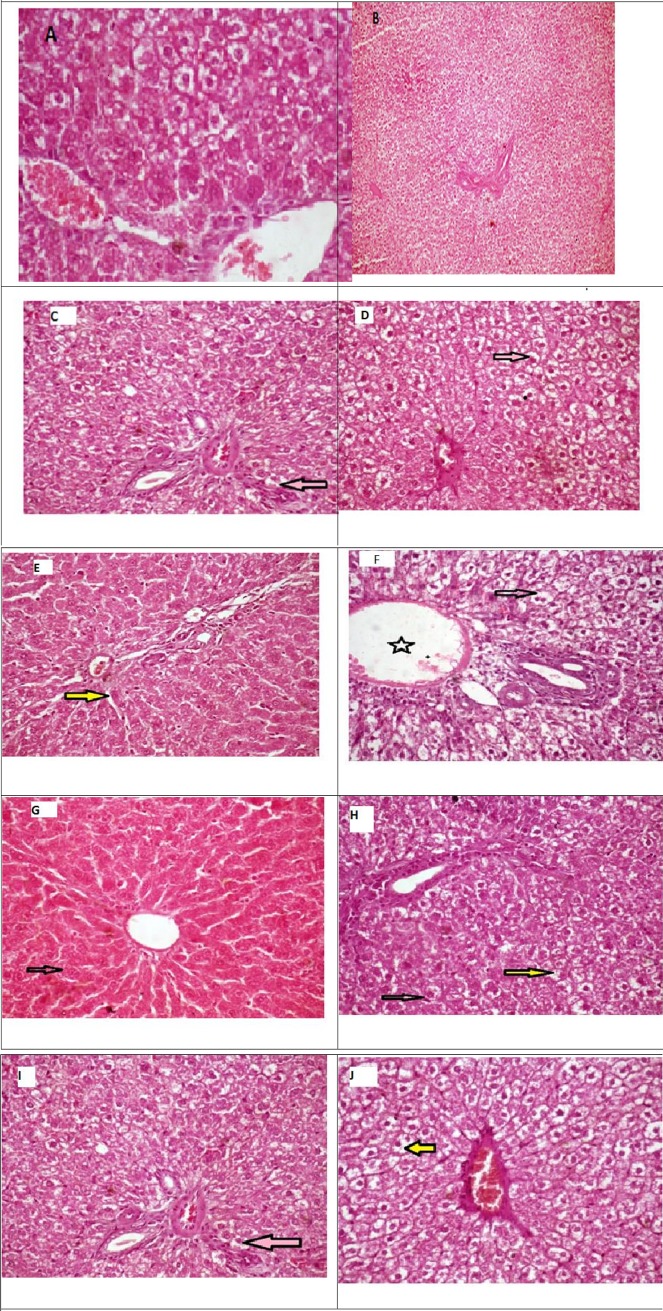
A and B are photomicrograph of livers of control rats (H&E 200 & 100.); (c) Photomicrograph of liver section of tramadol-treated group after single dose revealing mild vacuolar degeneration of hepatic cells (pink arrow) (H&E 200). Fig 2D is the Photomicrograph of liver section of tramadol-treated group after single dose revealing mild vacuolar degeneration of hepatic cells (pink arrow) (H&E 200). Fig 2E is the Photomicrograph of liver sections of tramadol + Curcumin group showed mild sinusoidal dilation after single dose treatments (yellow arrow) (H&E 200). Fig 2F is the Photomicrograph of liver sections of tramadol + Curcumin group showed dilation hepatic blood vessels (star) and vacuolar degeneration of hepatic cells (black arrow) after repeated dose treatments (H&E 400). Fig 2G is the photomicrograph of liver section of tramadol + Gallic acid treated- group showing cloudy swelling of the hepatic cells (black arrow) after single dose treatments (.H&E 200). Fig 2H is the Photomicrograph of liver section of tramadol + Gallic acid treated- group showed mild vacuolar degeneration of hepatic cells (yellow arrow) and Kupffer cell hyperplasia (black arrow) after single and repeated dose treatments (H&E 200). Fig 2I is the photomicrograph of liver section of tramadol + Curcumin + Gallic acid treated-group showed mild vacuolar degeneration of hepatic cells (pink arrow) after single dose treatments. (H&E 200). Fig 2J is the photomicrograph of liver section of tramadol + Curcumin + Gallic acid treated-group showed moderate vacuolar degeneration (yellow arrow) and congestion of hepatic blood vessels after repeated dose treatments. (H&E200).